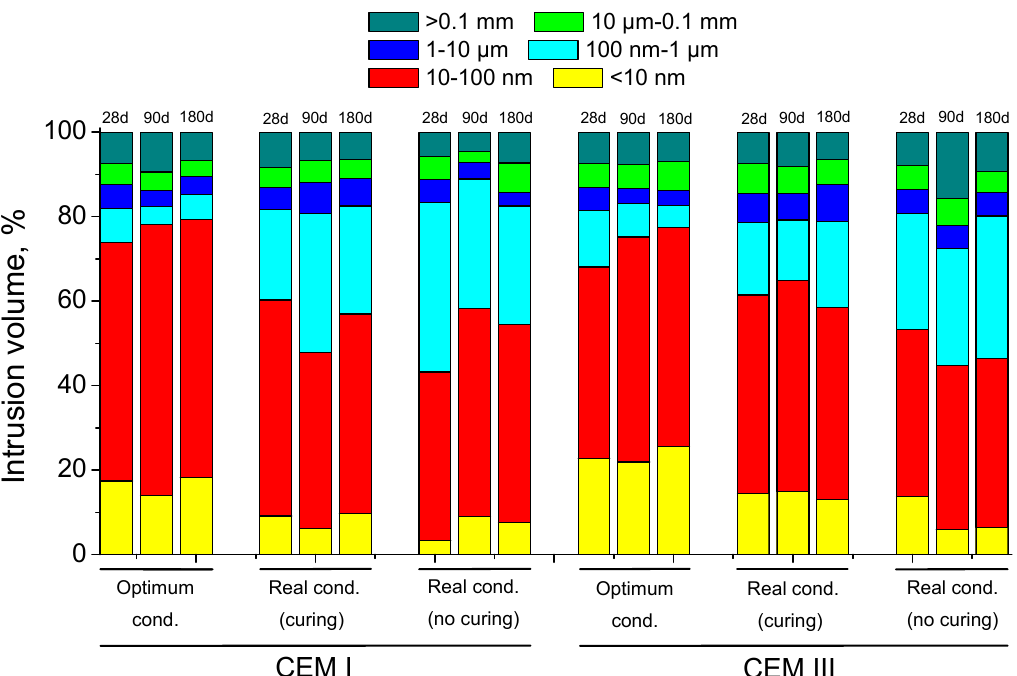
Figure 5. Pore size distributions for CEM I and III concretes obtained for each hardening condition.